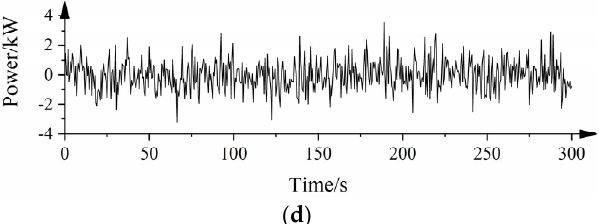
Figure 17. ( a ) The power output of each energy part; ( b ) The power output of the hydrogen fuel cell; ( c ) The power output of the LiFePO4 battery; ( d ) The power output of the ultracapacitor.